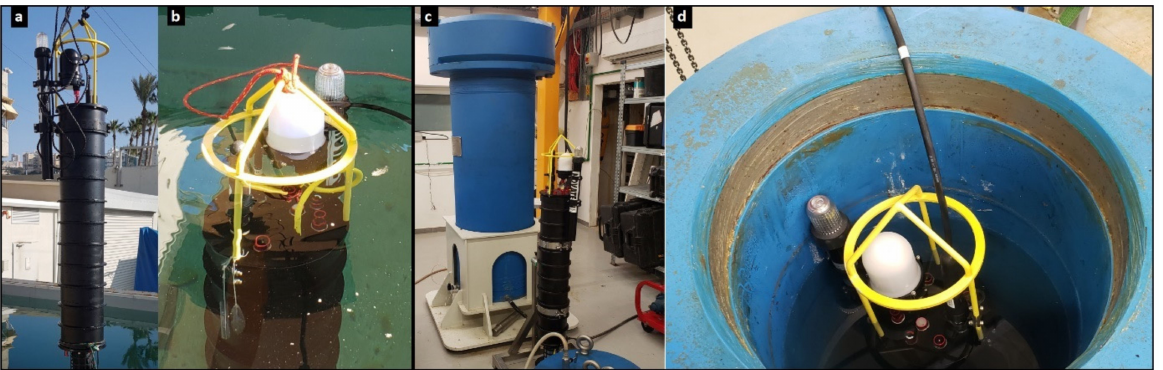
Figure 18. ( a ) float lowered into the pool; ( b ) on the surface as part of ballasting; ( c ) in front of the pressure chamber; ( d ) in the pressure chamber with cable leading to a PC.